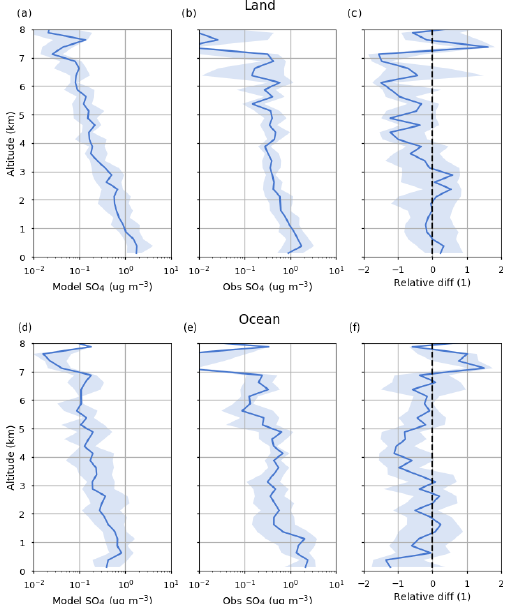
Figure C1. The vertical profiles of modelled (a) , observed (b) and fractional bias (c) in SO 4 mass concentration for measurements over land and ocean.